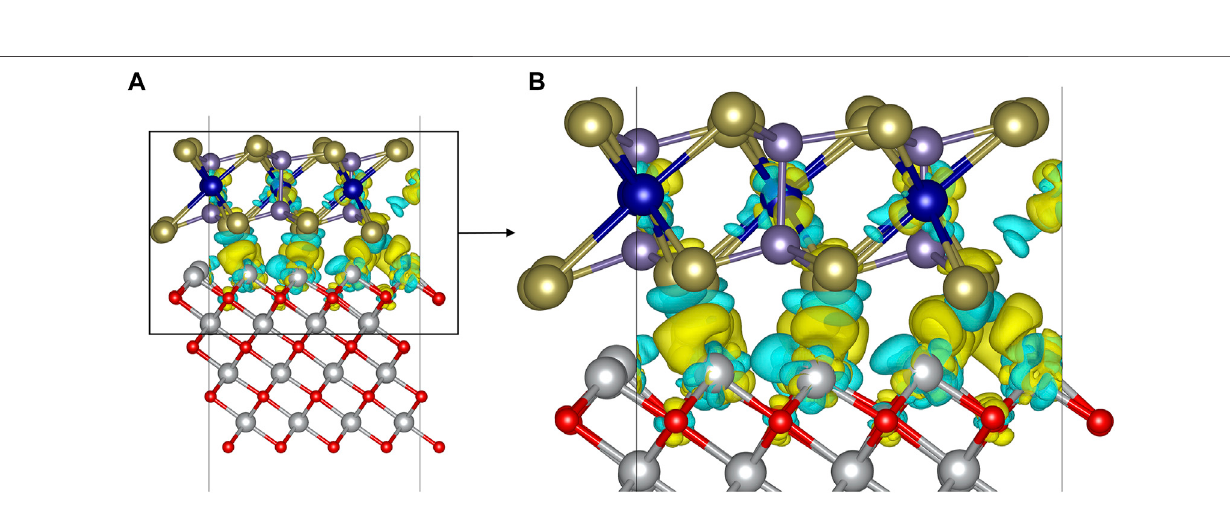
Frontiers in Materials |